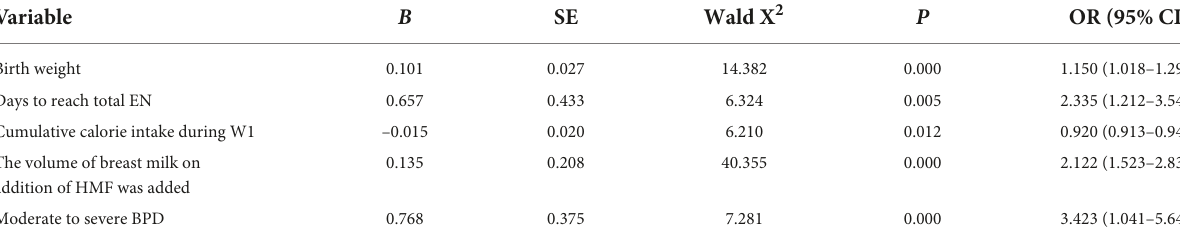
TABLE 5 Multivariate logistic regression analysis of the risk factors for the occurrence of “true